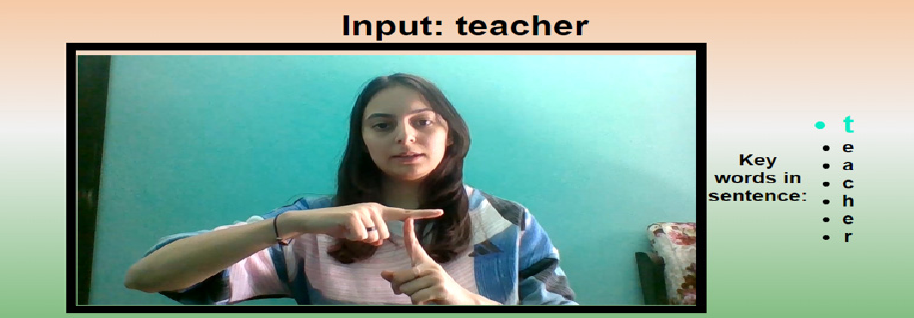
Figure 10. Case 3. Available video for letter ‘t’.